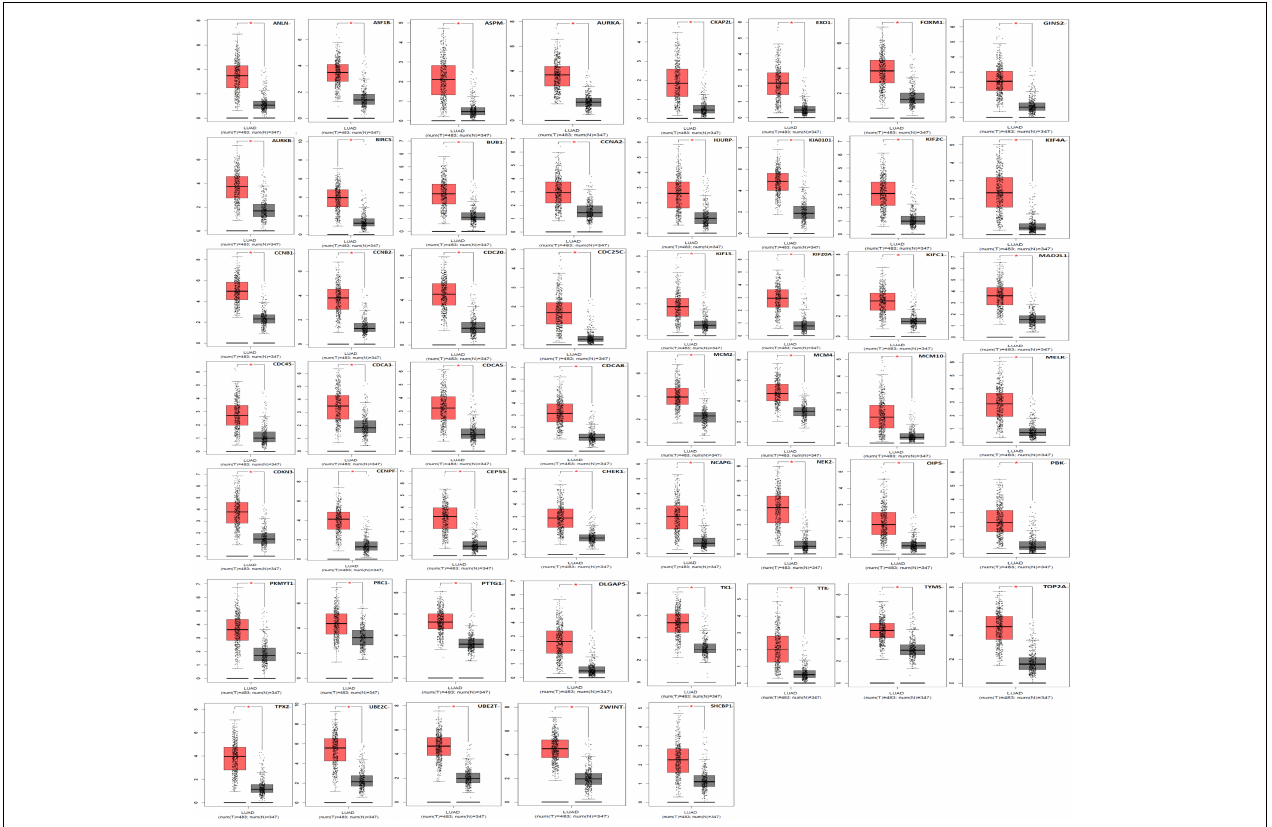
FIGURE 4 | A total of 53 of 58 genes are significantly upregulated in LUAD samples contrasted to normal lung samples (* P < 0.05).